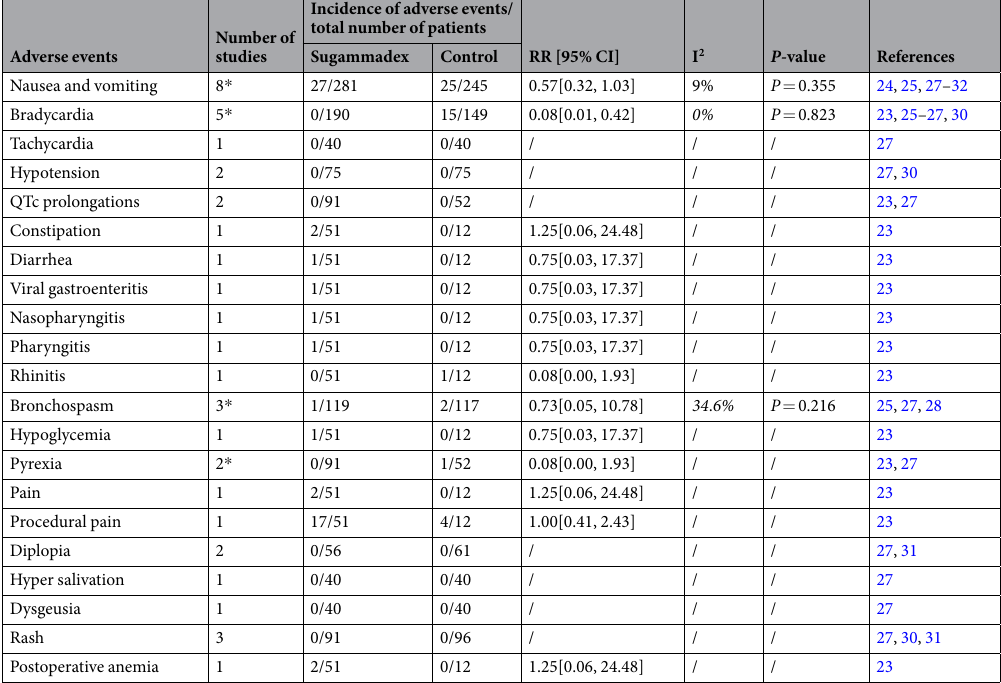
Table 2. The summary of reported secondary outcome (adverse events) in the included studies. * Several studies were excluded when relative risk was calculated because the incidences of two groups were both